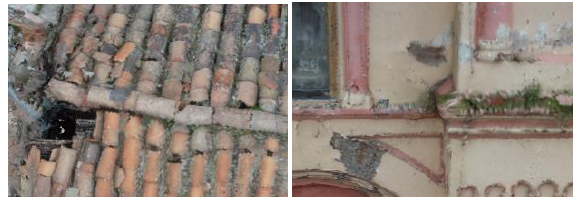
Figure 14 . Damages in the church of